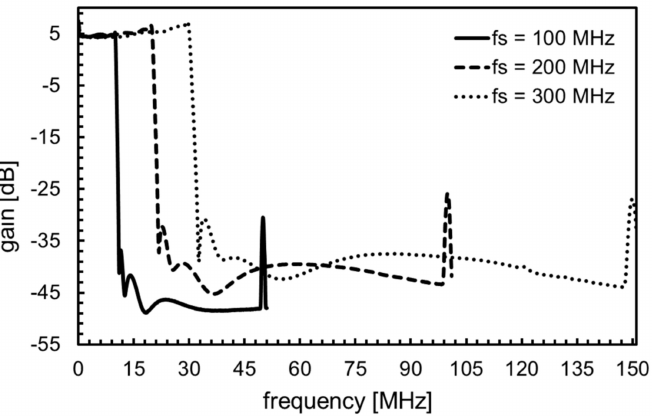
Figure 6. Measured LPF frequency response for different values of the sampling frequency.